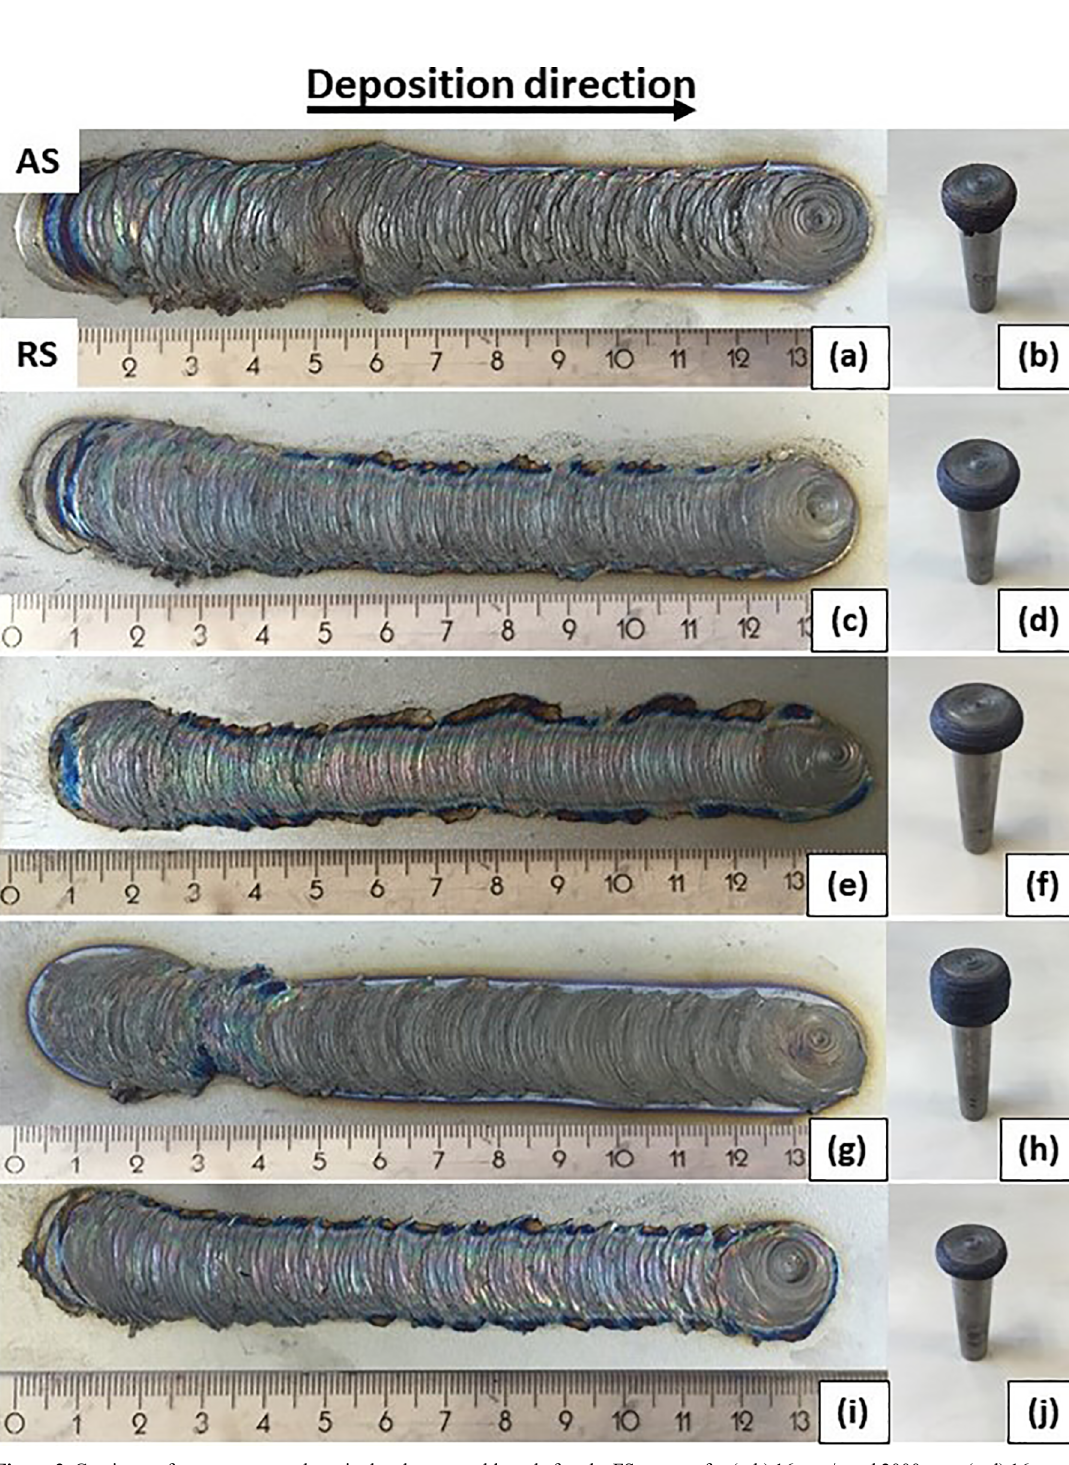
Figure 2. Coating surface appearance deposited and consumable rod after the FS process for (a-b) 16 mm/s and 2000 rpm, (c-d) 16 mm/s and 3000 rpm, (e-f) 16 mm/s and 4000 rpm, (g-h) 8 mm/s and 3000 rpm and (i-j) 24 mm/s and 3000